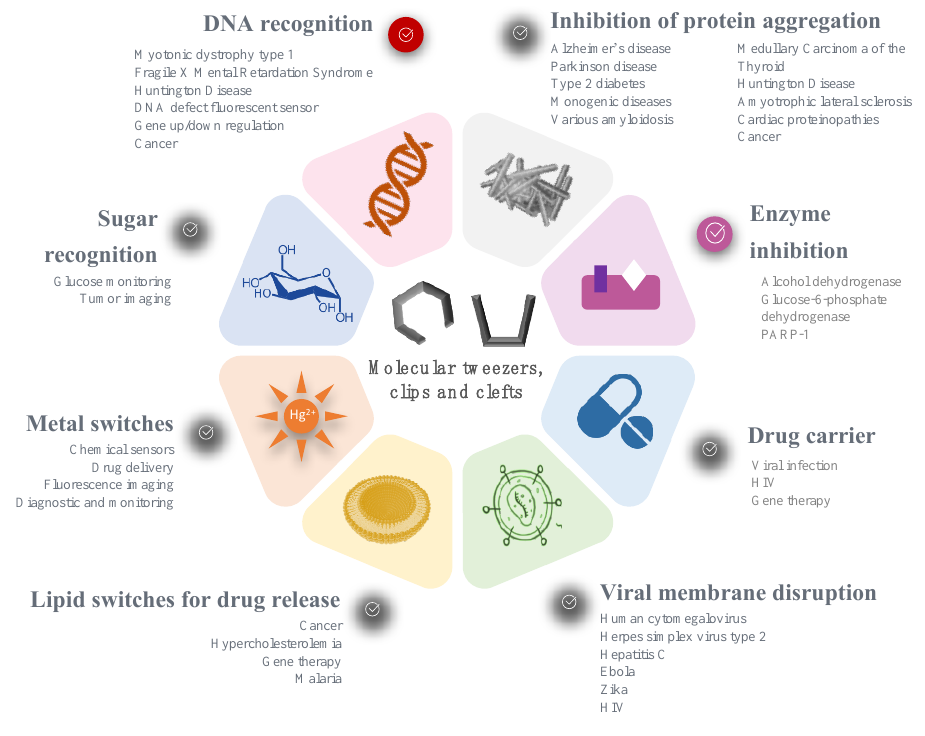
Figure 10. Overview of the pharmaceutical applications of molecular tweezers, clefts and clips.